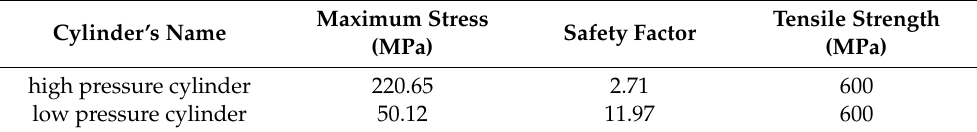
Table 4. Pressurized cylinder stress parameters.